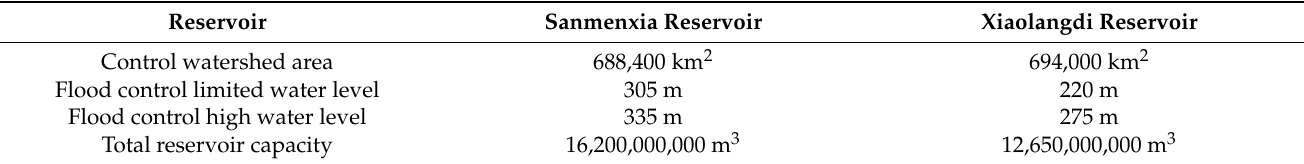
Table 1. Current situation of Sanmenxia and Xiaolangdi Reservoirs.